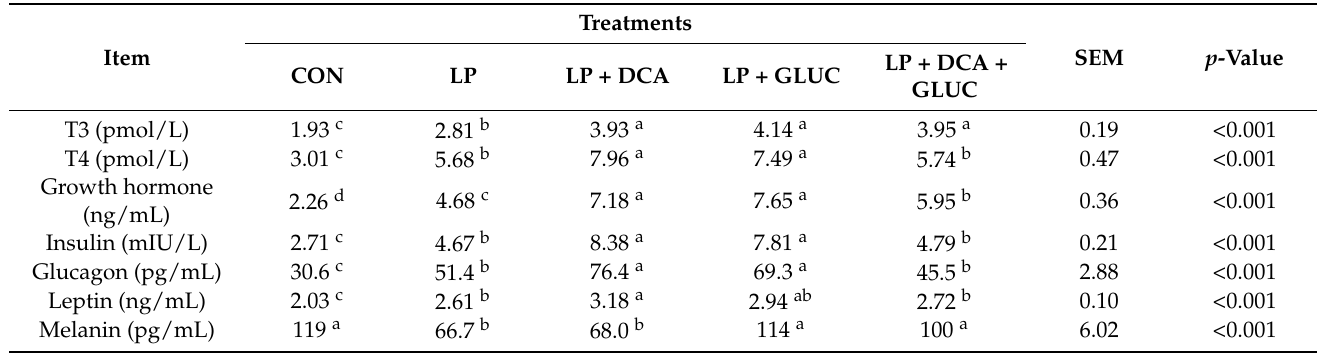
Table 2. Effects of supplementing low protein (LP) diets with sodium dichloroacetate (DCA) and glucose (GLUC) on the plasma hormone concentrations in growing-finishing pigs.